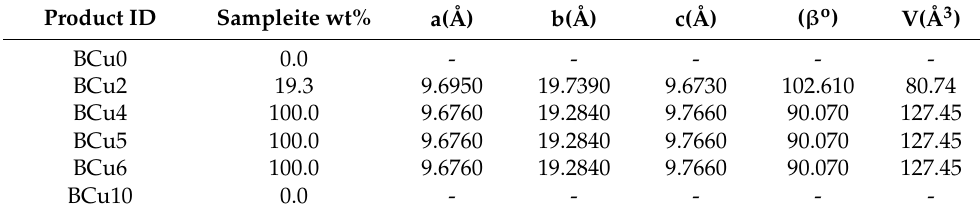
Table 3. The parameters of unit cell for sampleite-like mineral from XRD data (Rietveld